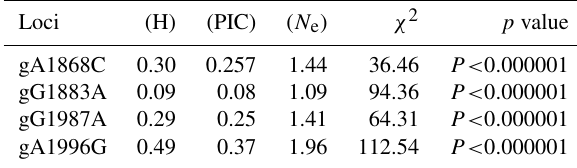
Table 2. Polymorphism of the mutation in the AMH exon